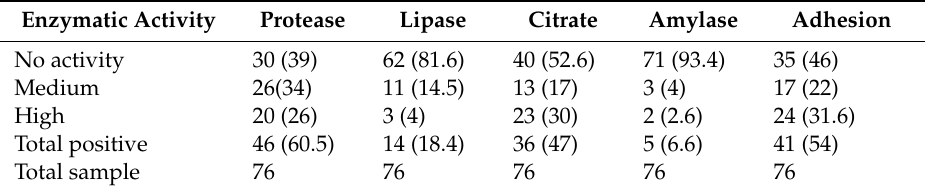
Table 3. Number of strains of LAB isolated from fresh vegetable sources with enzymatic and adhesion capacity and percentage (In parenthesis).